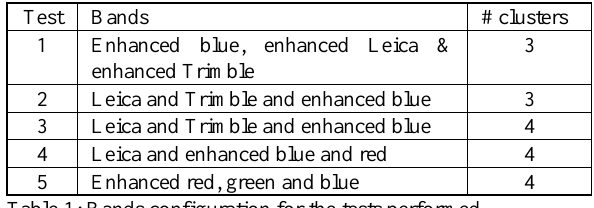
Table 1: Bands configuration for the tests performed.